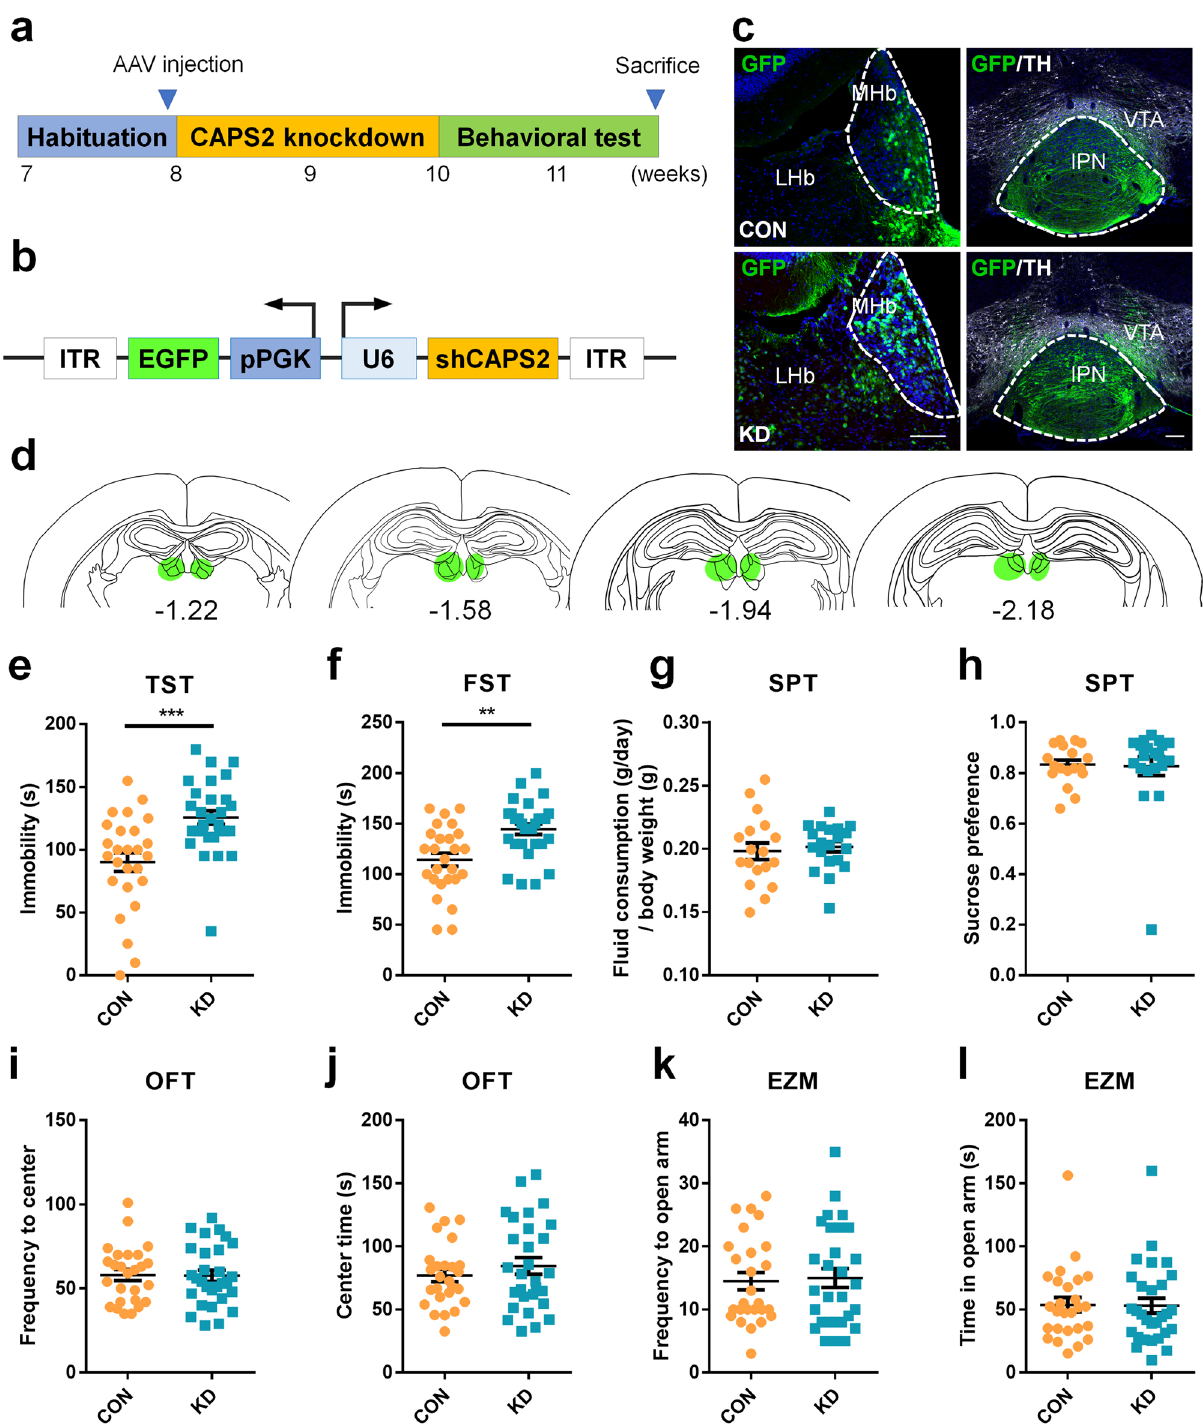
Figure 2. Effects of CAPS2 knockdown in the MHb on anxiety- and depression-like behaviors. ( a ) Experimental paradigm for behavioral testing of mice infected with the virus. ( b ) Schematic representation of the AAV vector engineered to induce CAPS2 knockdown. ( c ) GFP expression of AAV-sh-vehicle (CON) or AAV-sh-CAPS2 (KD) after 4 weeks of injection. Scale bars, 100 μm. ( d ) Diagram showing viral spread in the mouse brain. ( e–l ) Despair-like symptom and anhedonia-like symptom were examined by the tail-suspension test (TST, e ), forced swim test (FST, f ), and sucrose preference test (SPT, g and h ). Behavioral effects of expressing AAV- sh-CAPS2 in the MHb on anxiety levels were performed in the open field test (OFT, i and j ) and the elevated zero maze test (EZM, k and l ) and analyzed with Ethovision XT 12. AAV-sh-CAPS2 (KD) injected group showed increased immobility time in TST and FST, indicating despair-like symptoms, but no difference in anxiety-like and anhedonia-like symptom. Data represent mean ± SEM, ** P < 0.01, *** P < 0.001 ( e–f , i–l ; CON, n = 26; KD, n = 29 mice; TST: P < 0.001; FST: P = 0.001; OFT, frequency to center: P = 0.924, OFT, center time: P = 0.379; EZM, frequency to open arm: P = 0.807, EZM, time in open arm: P = 0.942; g and h ; CON, n = 18; KD, n = 20 mice; SPT, fluid consumption: P = 0.637, SPT, sucrose preference: P = 0.892; Student’s t